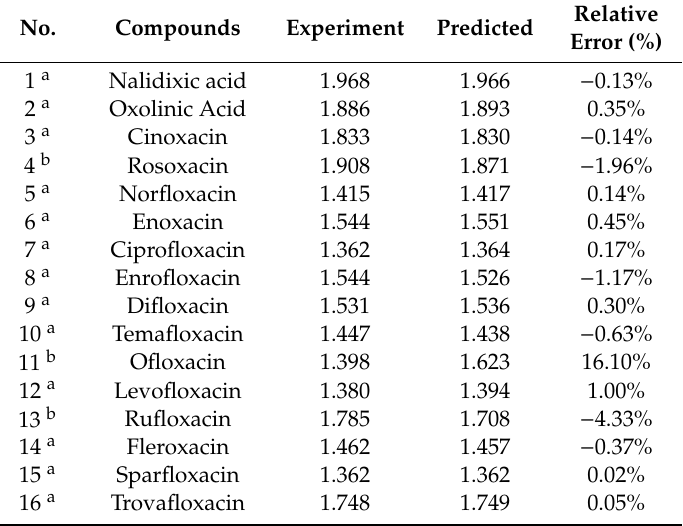
Table 1. Experimental and model-predicted value of Log f b .